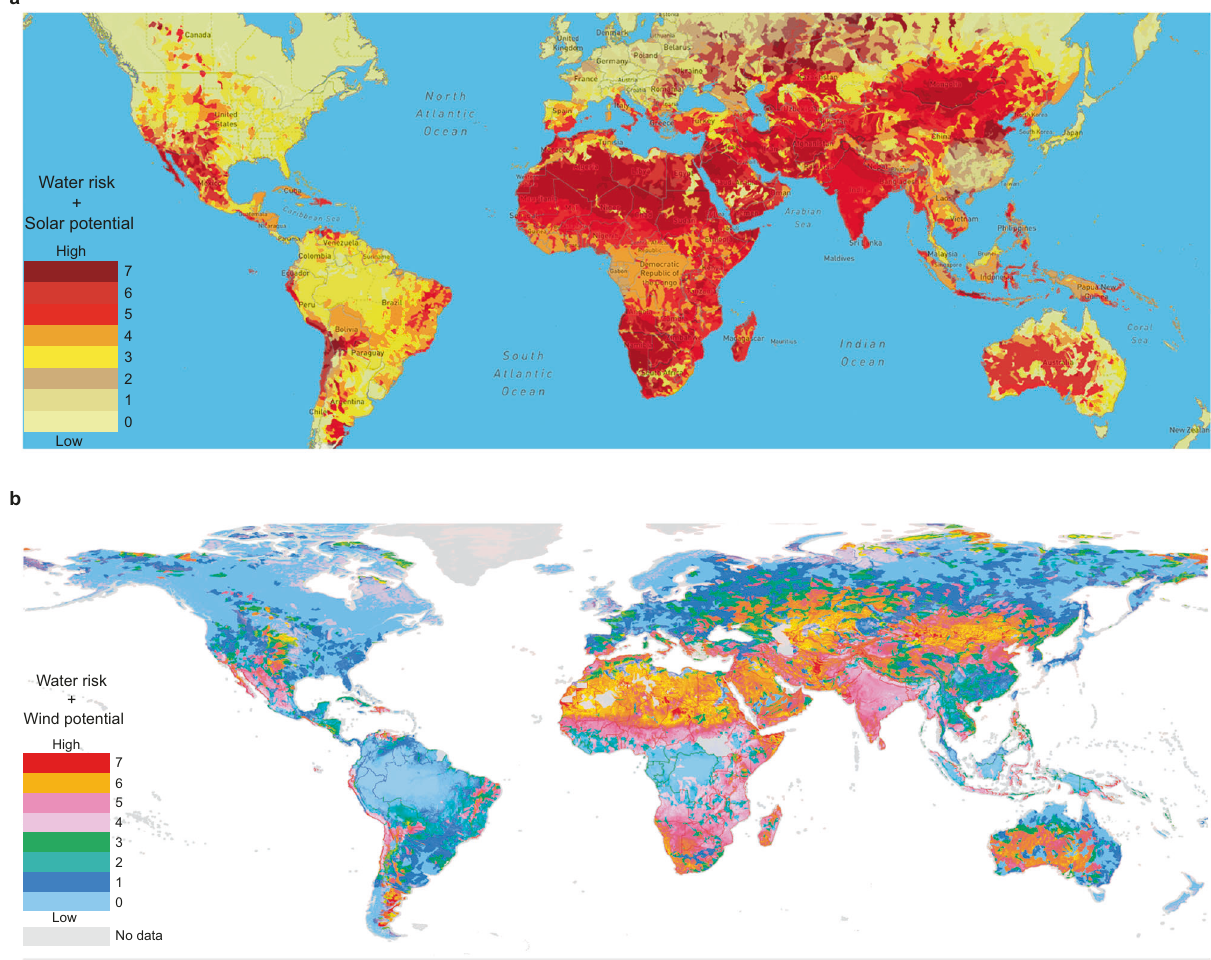
Fig. 1 | Superimposedatlas of water riskandthe renewableenergy. a water risk andsolarenergypotential ;b waterriskandwindenergypotential(excludingcoast areas). Separate maps are available in Supplementary Fig. 1 – 3. Source: